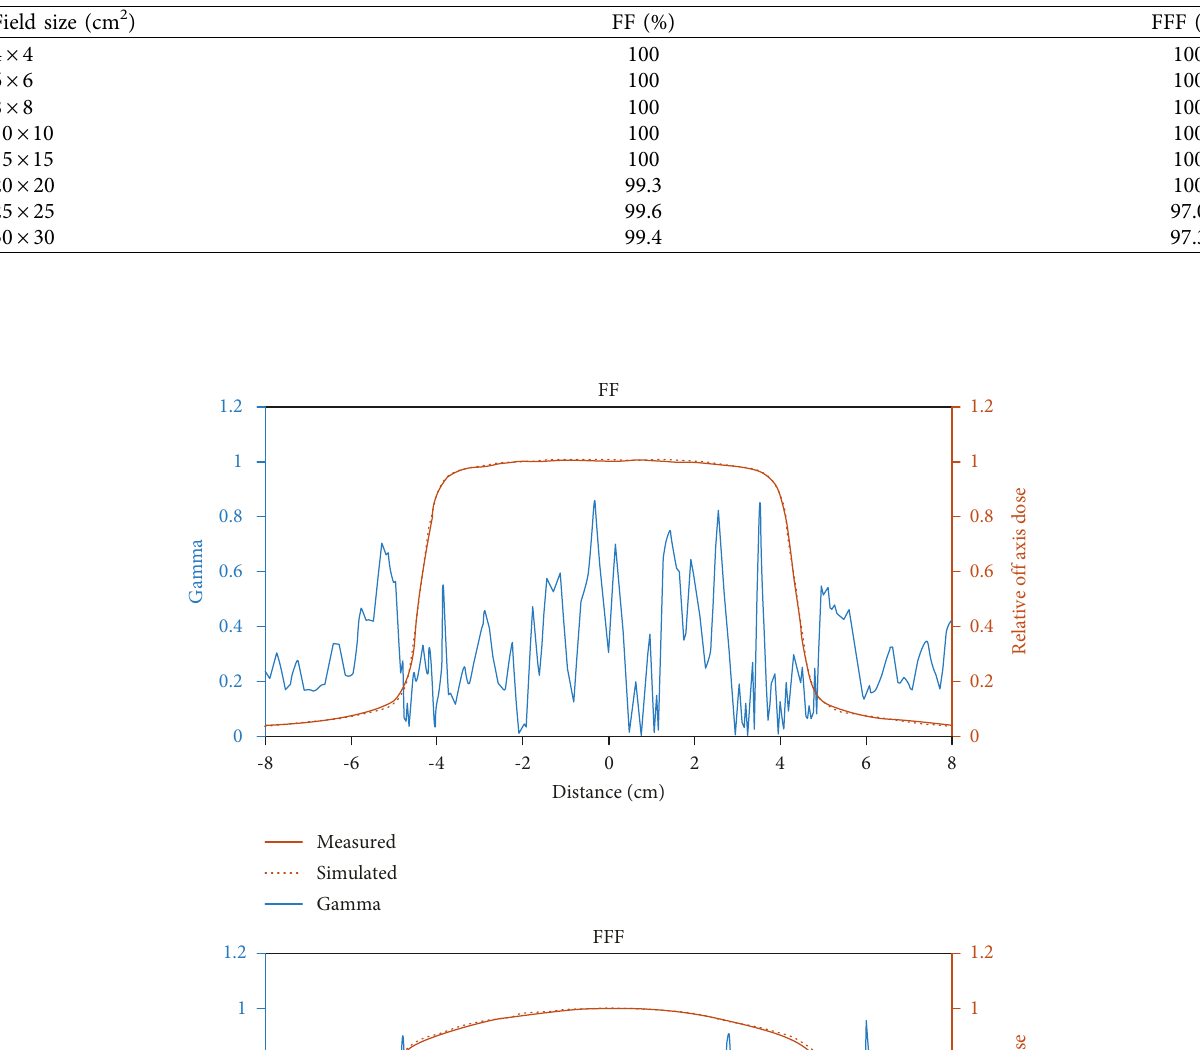
Table 4: Gamma passing rates of off-axis dose curves for different field sizes (cm 2 ) at 10cm depth in FF mode and FFF mode when the gamma criteria is 1 mm/1% (local dose).